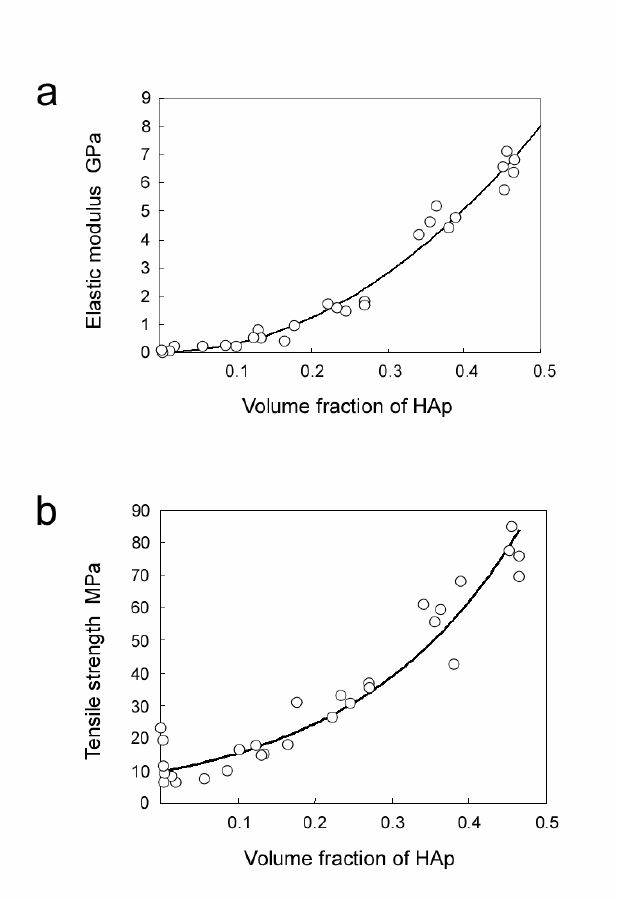
Fig. 5 Changes in elastic modulus (a) and tensile strength (b) by gradually eliminating minerals from